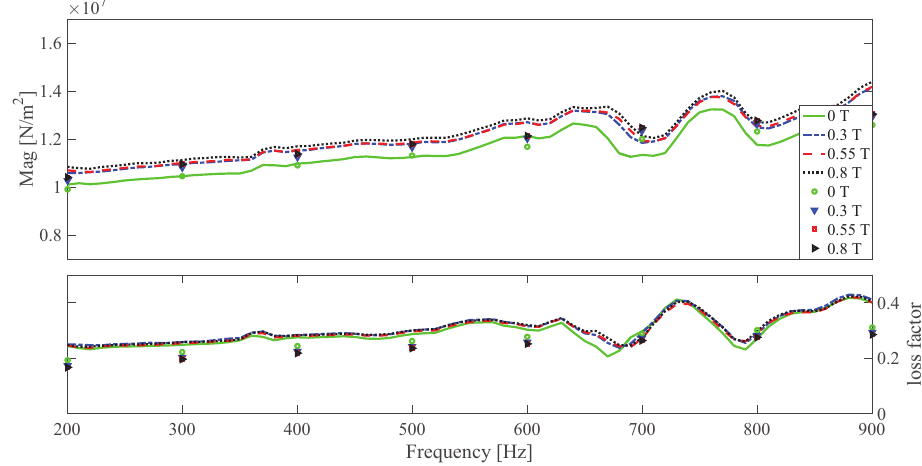
Figure 8. The magnitude and loss factor of the dynamic shear modulus versus frequency at 0.005 strain amplitude and 273K. Lines and symbols are the measurement and simulation results, respectively.